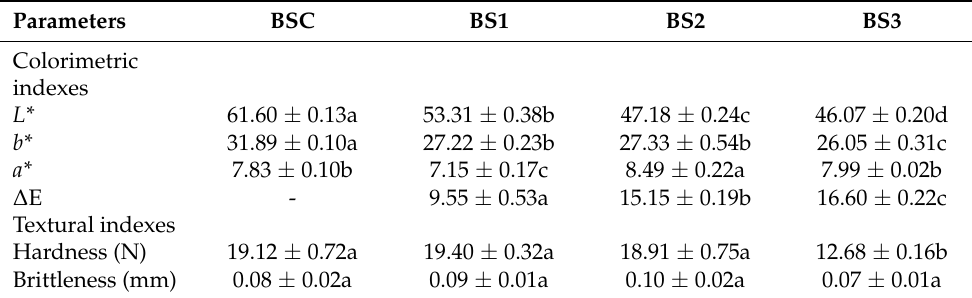
Table 3. Mean values, standard deviation, and results of statistical analysis of the colorimetric and textural properties of GF